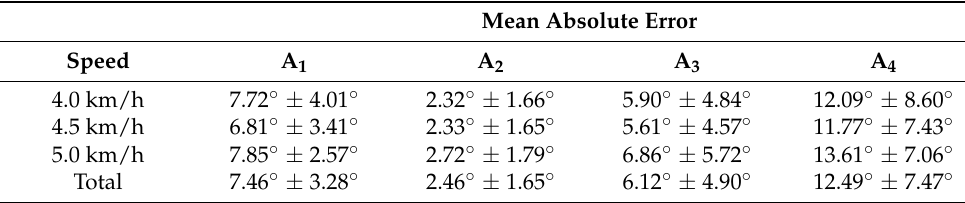
Table 1. Average of the MAE during the comparison of the differences calculated by the wear- able and the Aktos-t system during the activity of walking. The results are shown in the format mean ± standard deviation.